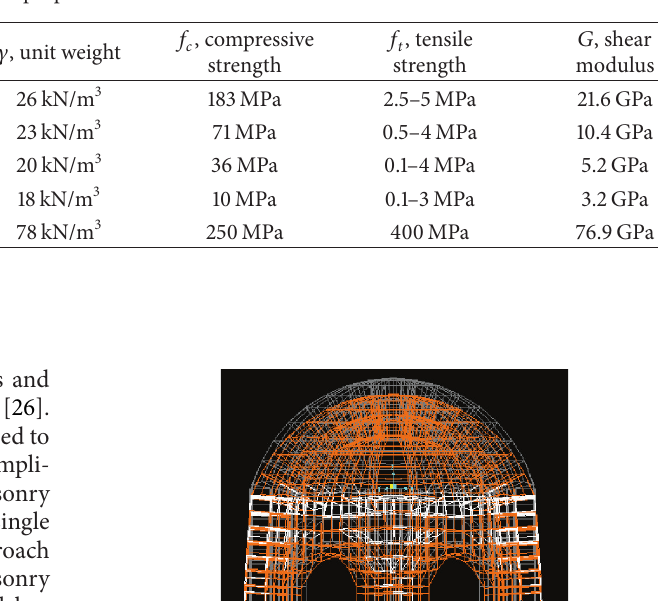
Table 2: Physical properties of tomb materials.